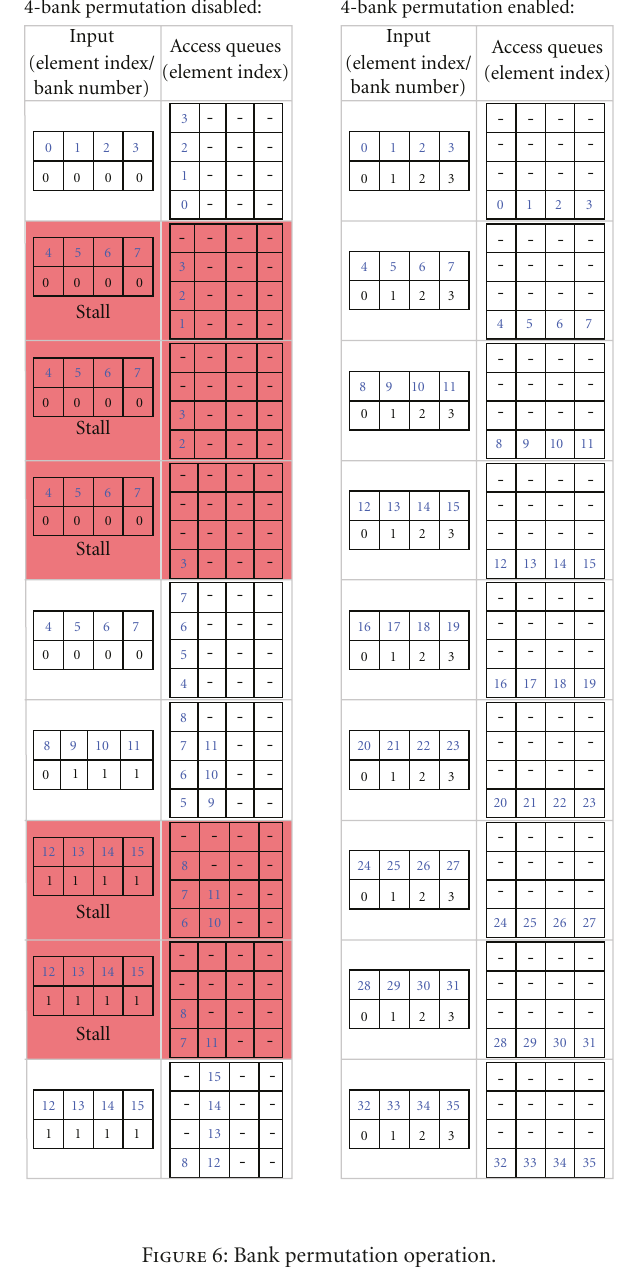
Figure 6: Bank permutation